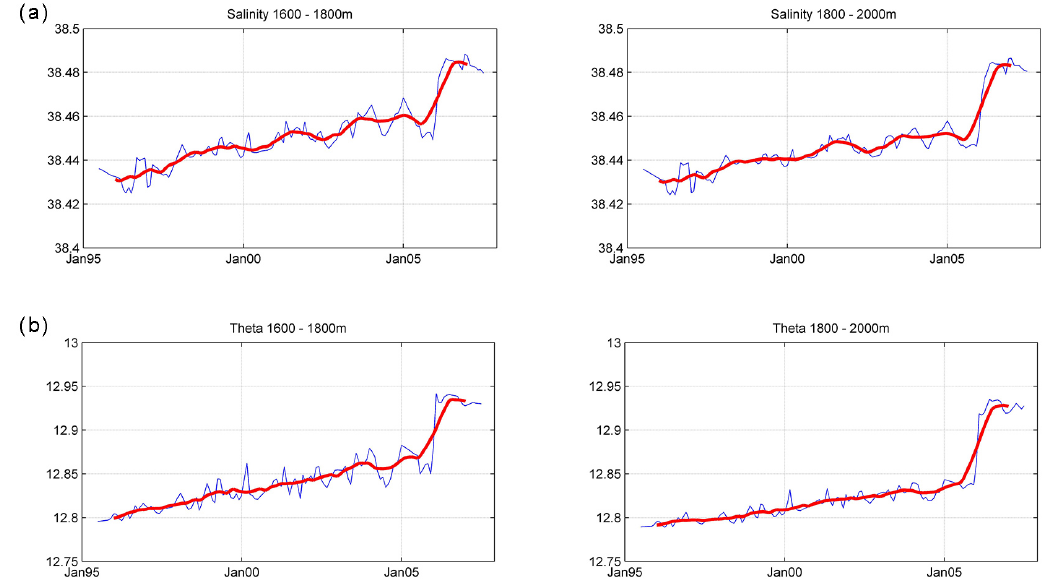
Figure 4. Time series average (a) salinity and (b) potential temperature in the layers 1600–1800m and 1800–2000m at the DYFAMED station in the Ligurian Sea. Monthly values are plotted in blue while running mean 13-month average values are plotted in